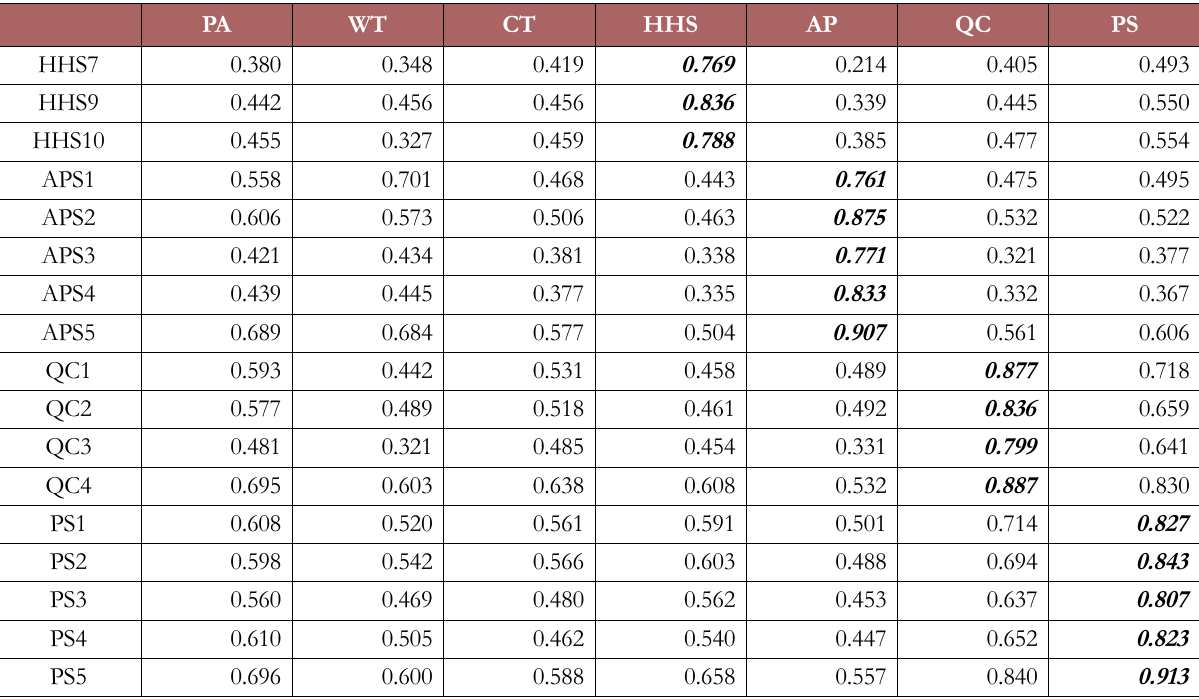
Table 5. Cross-loadings results